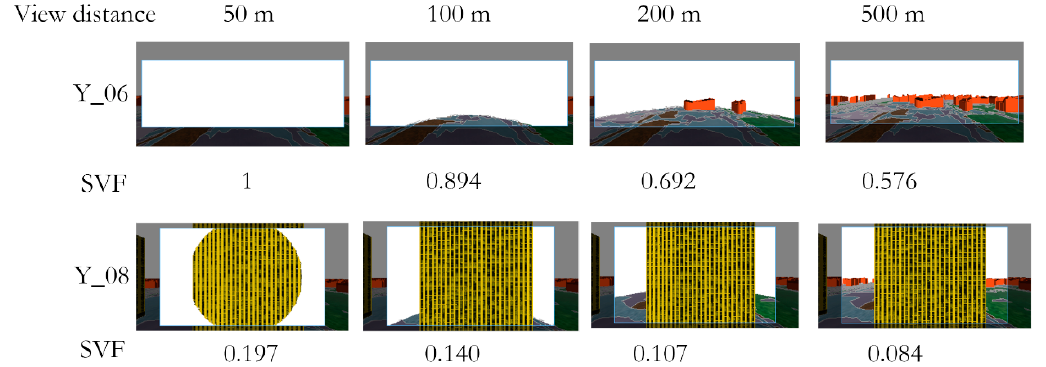
Figure 8. SVF change of Y_06 and Y_08 under different view distances.